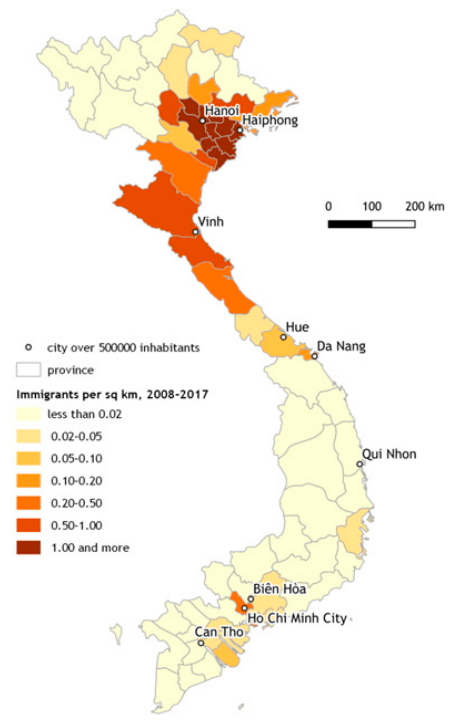
Figure 2. Immigrants’ places of birth by states: those who migrated from the USA to Czechia between 2008 and 2017, including both permanent and temporary residence permits. Source: our own research.